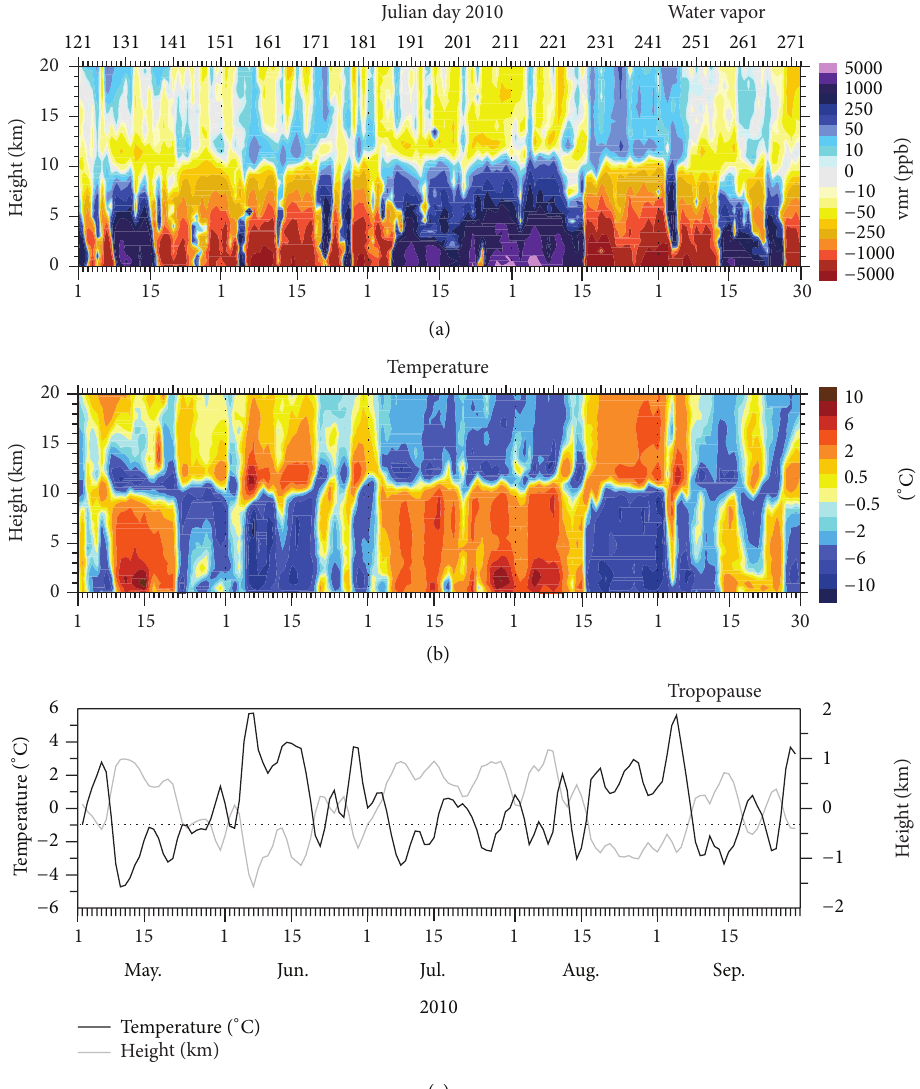
Figure 5: The time-height section of (a) water vapor anomalies in May–September 2010, calculated using radiosonde data from 8 upper air stations located in the north of ER (see Table 1), (b) the same, but for temperature. (c) The anomalies of the tropopause height (grey line) and temperature (black